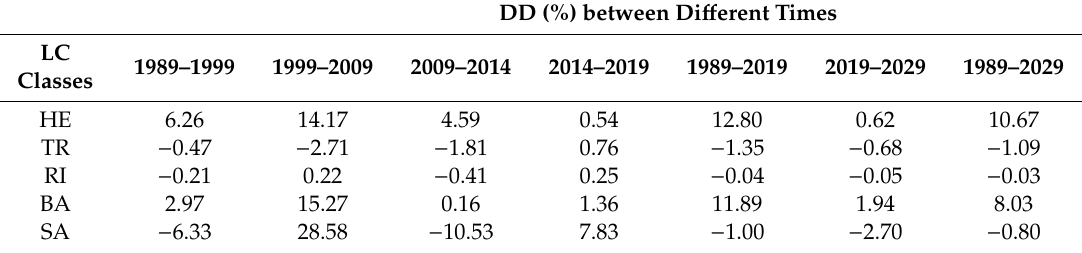
Table 4. Dynamic degrees (DD) (%) estimation between di ff erent times (1989–2029) based on LC total area coverage (ha) (adopted from Table 3).